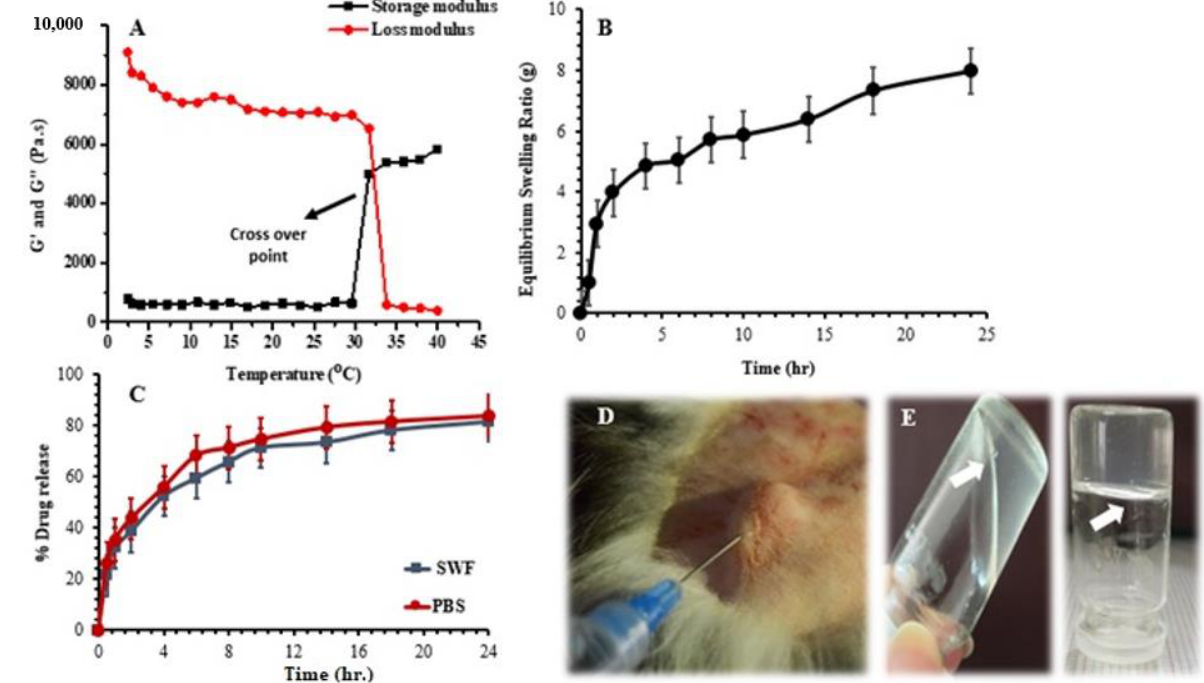
Figure 4. ( A ) Effect of temperature on changing the viscosity of injectable hydrogel by changing the shear rate; ( B ) equilibrium swelling ratio of thermosensitive injectable hydrogel; ( C ) percent drug release vs. time profile of injectable hydrogel; ( D ) in situ gelation after subcutaneous administration of injectable hydrogel in rabbits through 26-guage needle syringe; ( E ) pictorial representation of increasing viscosity due to which the gel faces difficulty in